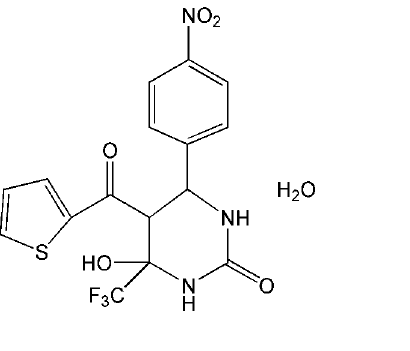
Data collection: CrystalClear-SM Expert (Rigaku, 2009); cell refinement: CrystalClear-SM Expert ; data reduction: CrystalClear-SM Expert ; program(s) used to solve structure: SHELXS97 (Sheldrick, 2008); program(s) used to refine structure: SHELXL97 (Sheldrick, 2008); molecular graphics: CrystalStructure (Rigaku, 2009);